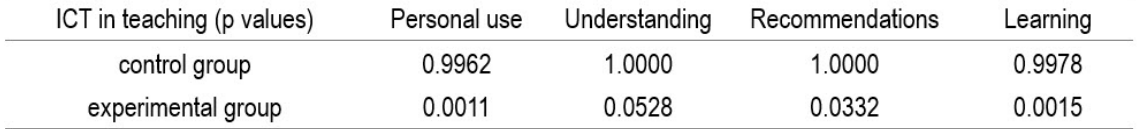
Research results for experimental and control groups for our examined factors (p